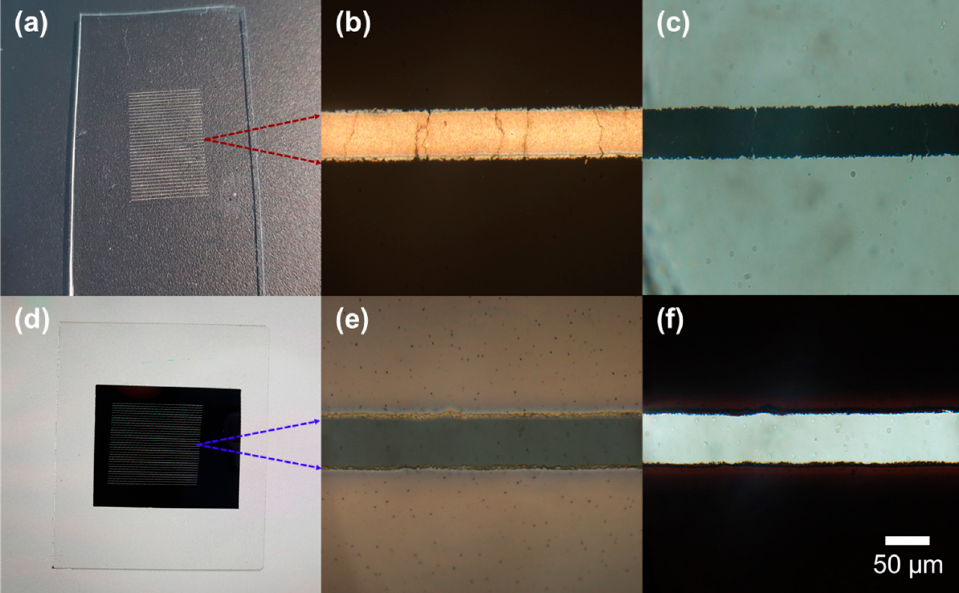
Figure 2. Optical images of ( a – c ) PDMS acceptor and ( d – f ) Ag NP ink donor on glass substrate; ( a , d ) Photographs; ( b , e ) Reflection optical microscope images; ( c , f ) Transmission optical microscope images.